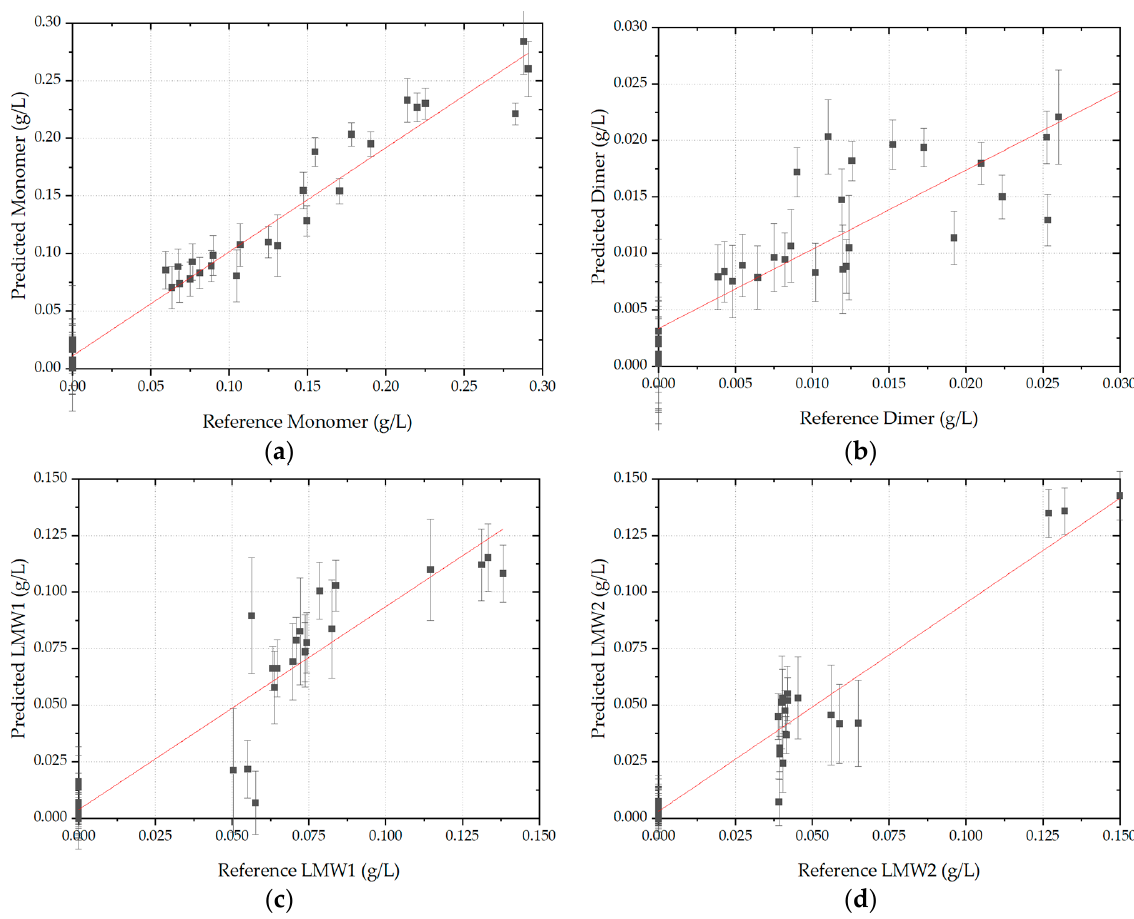
Figure 11. Prediction of process data using combination of DAD and fluorescence. IgG concentration ( a ), Dimer concen ‐ tration ( b ), LMW 1 ( c ), LMW 2 ( d ).